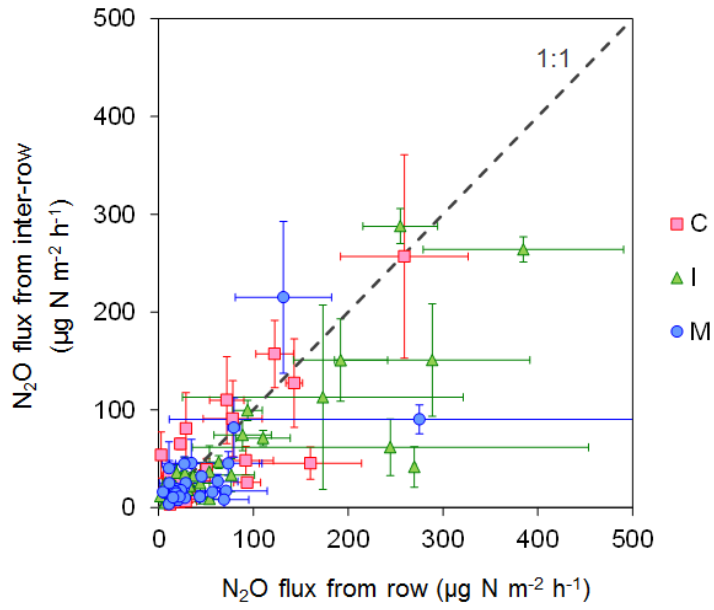
Figure 2. Comparison of N 2 O flux from row and inter ‐ low during the soybean cultivation period after ridging. Error bars indicate standard error. C: control; I: immature compost; M: mature compost. The annual CH 4 emissions did not differ significantly among the years and the plots (Table 1).